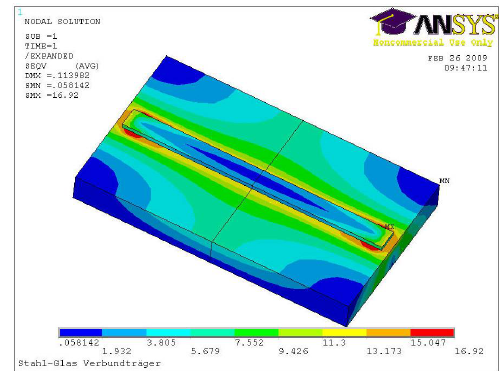
Figure 7: FE modelling of a push out test subjected to tension loading bonded with a two-component polyurethane – stress peaks at the local discontinuities in the corner regions of the joint